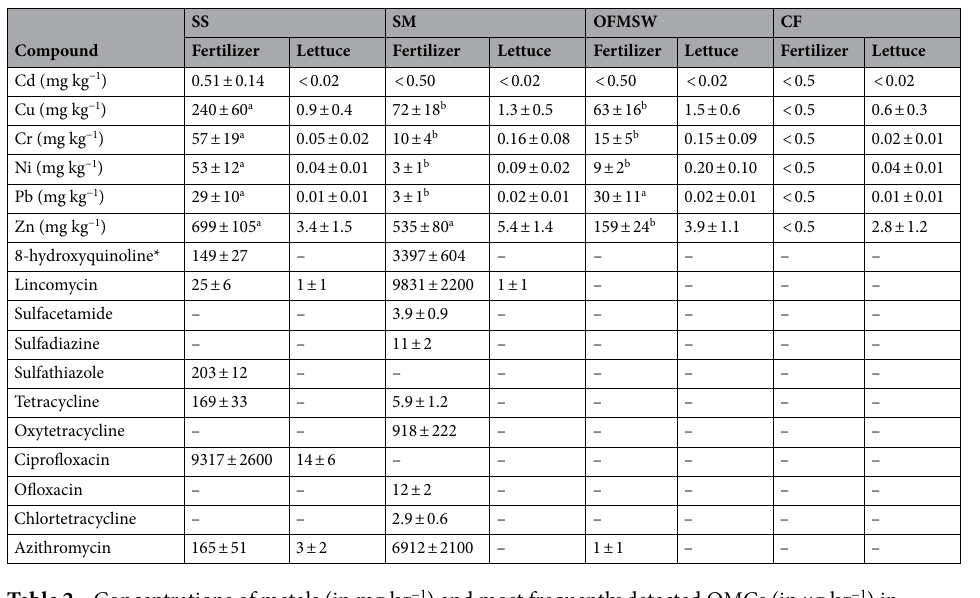
Table 2. Concentrations of metals (in mg kg −1 ) and most frequently detected OMCs (in µg kg −1 ) in fertilization products (n = 3) and lettuce samples (n = 5). Results are shown in dry weight (dw) for fertilisers and in fresh weight (fw) for lettuce crops. Different lowercase letters indicate statistically difference ( p < 0.05). –:Non detected. *Intermediate in the degradation of several antibiotics. REGULATION OF THE EUROPEAN PARLIAMENT AND OF THE COUNCIL laying down rules on the making available on the market of EU fertilizing products (PE-CONS 76/18. 2019) stablished a threshold values of metals in fertilizers as follows: Cd 1.5 mg kg −1 ; Cu 300 mg kg −1 ; Cr 100 mg kg −1 ; Ni 50 mg kg −1 ; Pg 120 mg kg −1 , and Zn 800 mg kg −1 . Statistical analysis were conducted using SPSS 25